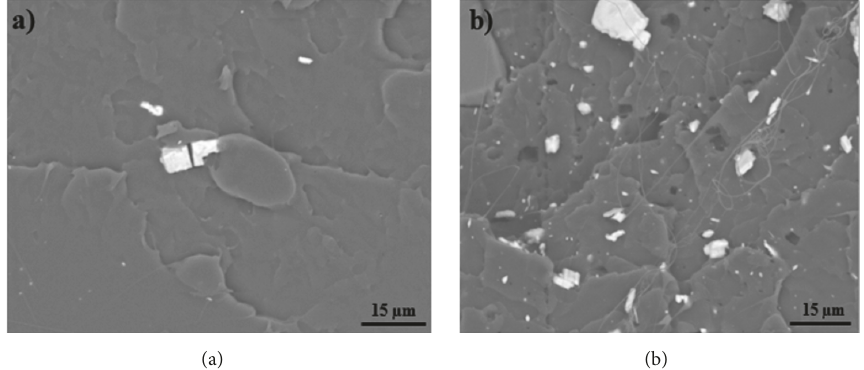
Figure 9: SEM micrographs of fracture surfaces of PLA loaded with P-glass at (a) 2.5% by weight and (b) 10% by